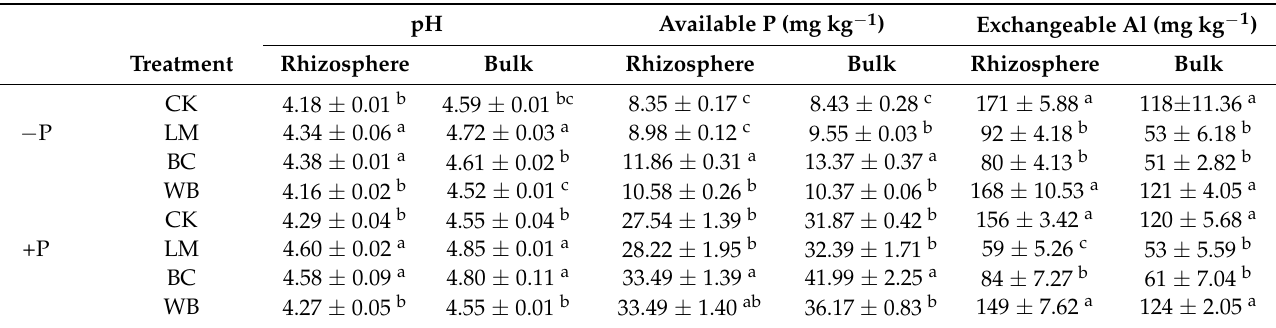
Table 2. Effect of biochar and P supply on major soil constraints (pH, exchangeable Al and available P) in the rhizosphere and bulk soil.